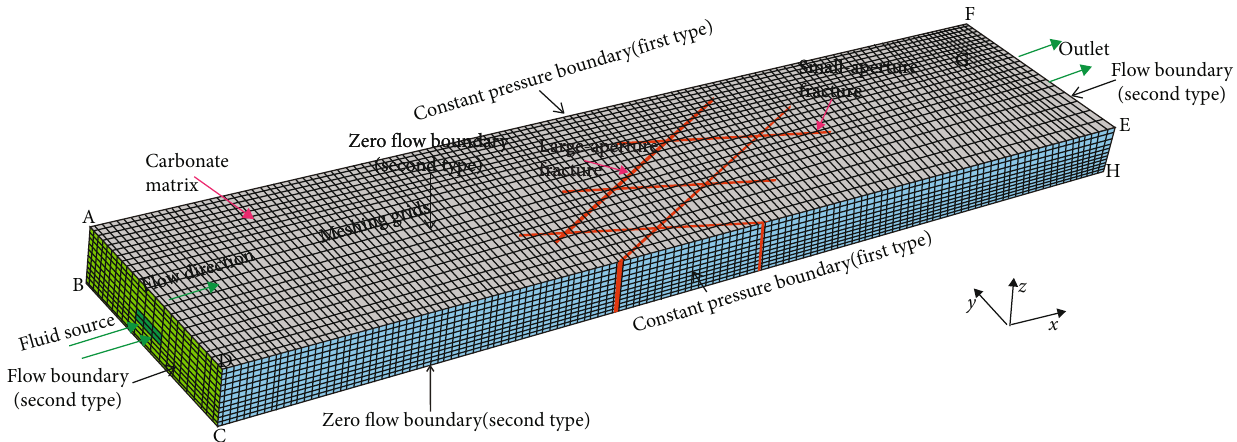
Figure 3: Schematic diagram of three-dimensional multiple geological